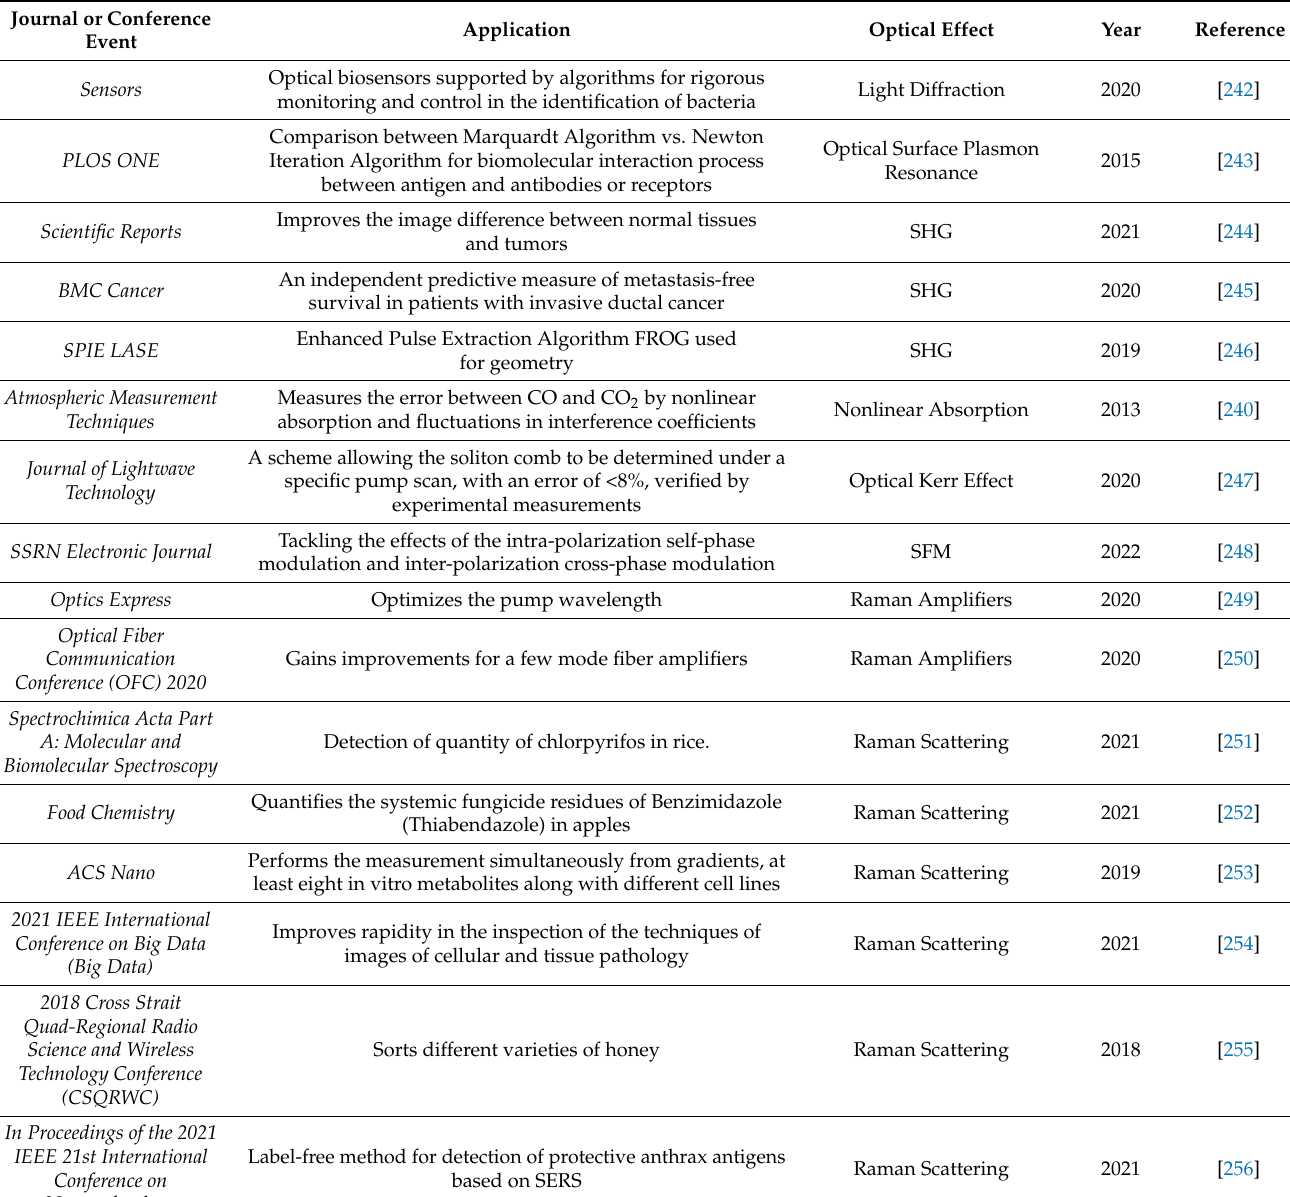
Table 3. NLO processes assisted by computational